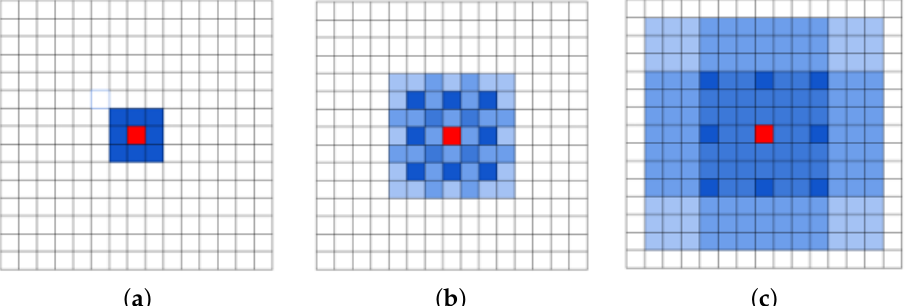
Figure 2. Impact of stacking dilated convolutions with different dilation rates on a 3 × 3 filter [42]: ( a ) F 1 is produced from F 0 by a 1-dilated convolution, ( b ) F 2 is produced from F 1 by a 2-dilated convolution, and ( c ) F 3 is produced from F 2 by a 3-dilated